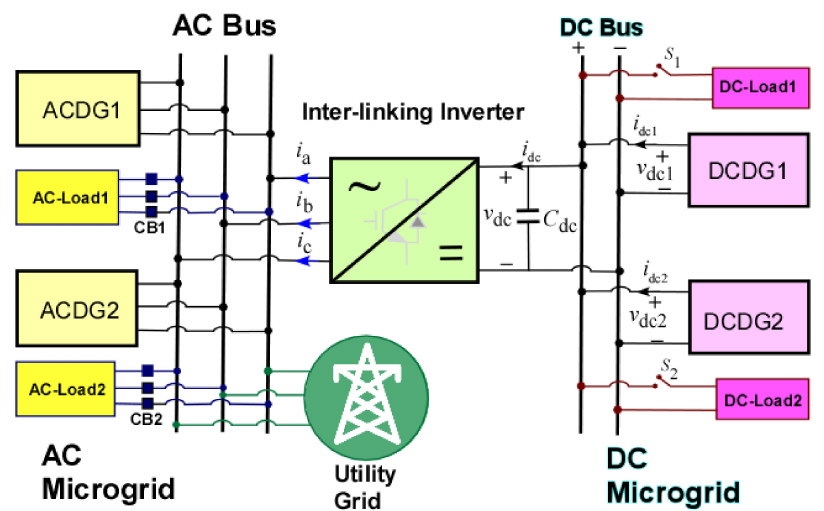
Figure 3. The layout of modelled hybrid MG.